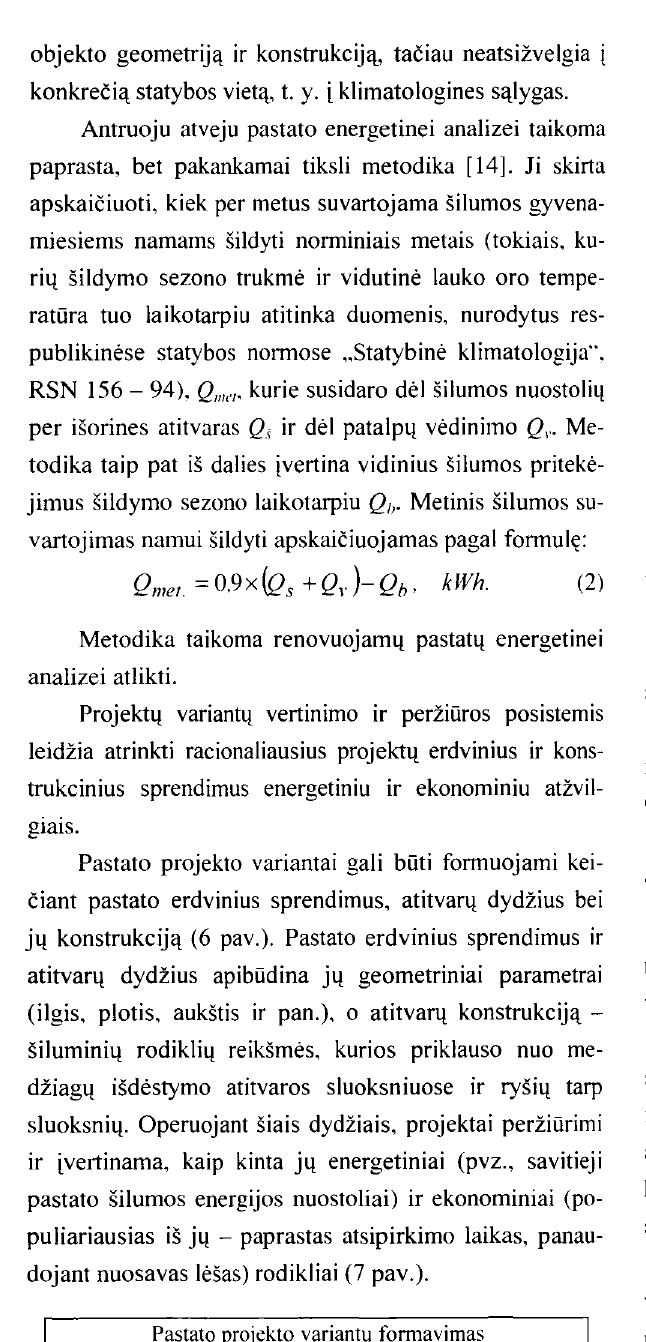
Fig 7. The building project variant evaluation